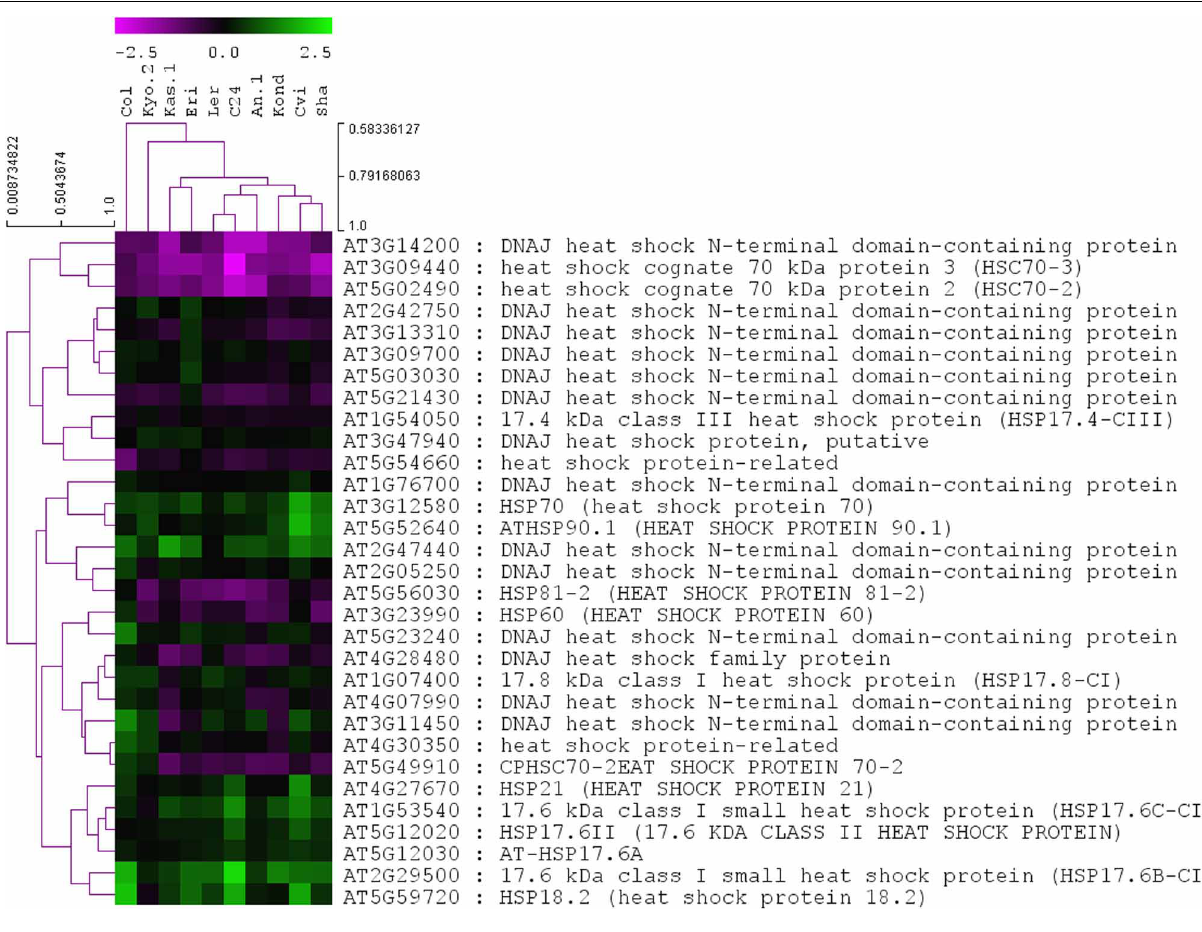
correlation coefficient with average linkage method. The P -values and log2 fold-change values associated with all of the 145 Hsp s are provided in Table